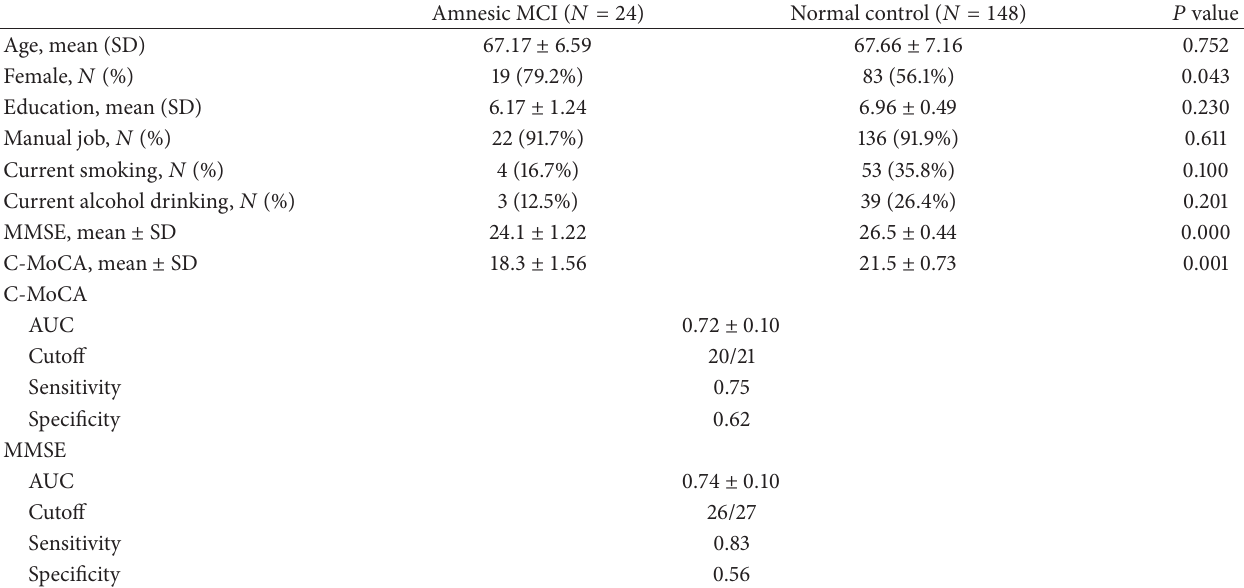
Table 1: Demographic characteristics of participants and mean C-MoCA and